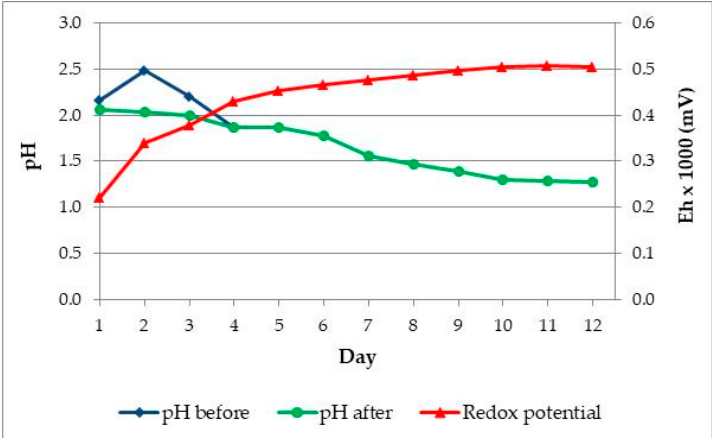
Figure 3. The changes pH and Eh (mV) vs. time in Adaptation II. Black circles—pH before H 2 SO 4 addition; blue squares—pH after H 2 SO 4 addition; red triangles—Eh (mV).